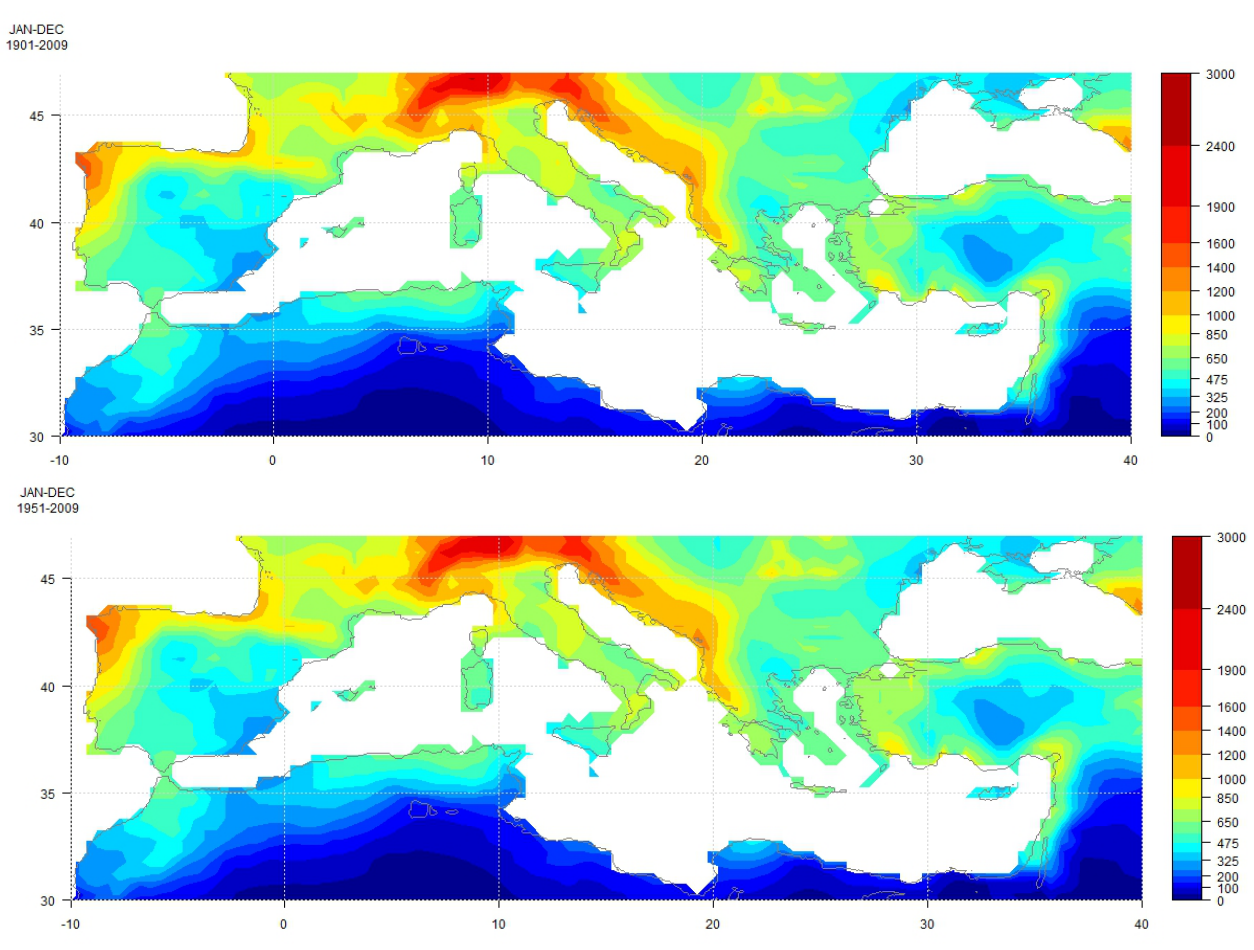
Fig. 1. Spatial distribution of mean annual precipitation concerning gridded datasets (CRU TS 3.1), for 1901–2009 (upper graph) and 1951–2009 (lower graph).